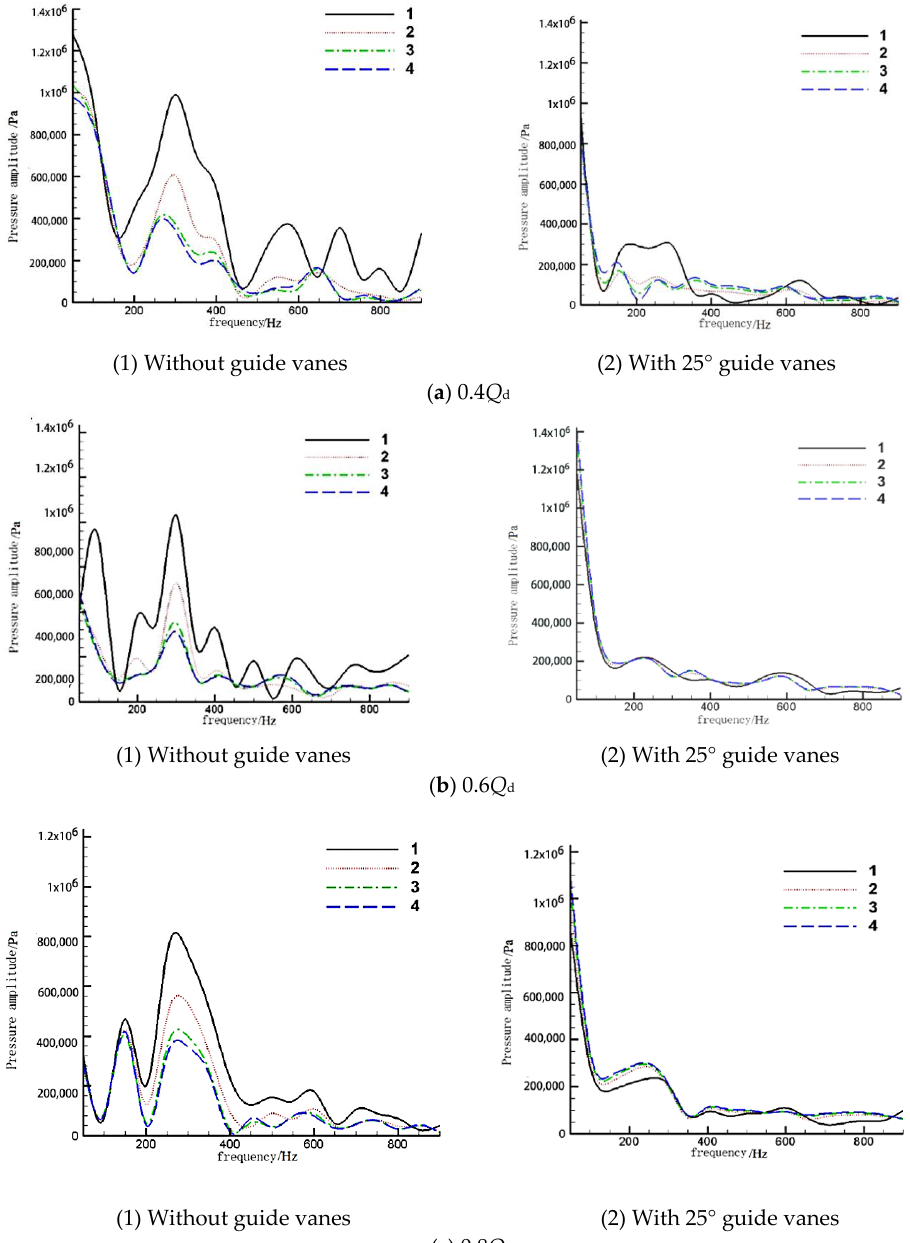
Figure 15. Frequency domain diagram of pressure pulsation in Section VI for different flow rates: ( a ) 0.4 Q d , ( b ) 0.6 Q d , ( c ) 0.8 Q